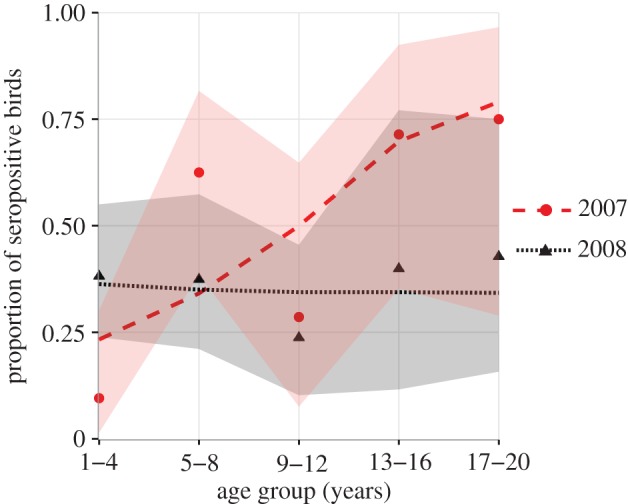
Proportion of birds observed to respond to H5N2 in five age groups for each sample year (dots), with 95% CIs for proportions shaded (2007, pale red; 2008, dark grey). Lines represent the mean proportion of birds in each age category expected to respond to H5N2, based on the fitted probability of effect of age and sample year (2007, red, wide-dash; 2008, black, narrow-dash) on response to H5N2 as determined by GLM with logit link. As the inclusion of sex in the model does not significantly affect the probability of having a response, for simplicity, expected number of birds is based on the fitted probability estimated for a model without a sex term. (Online version in colour.)